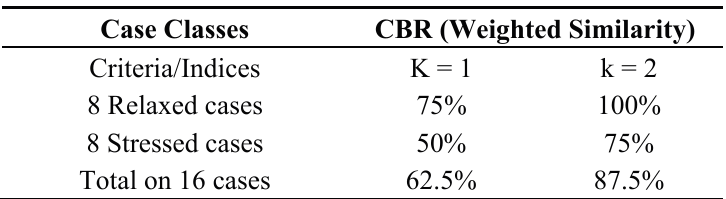
Table 2. Representation of percentage of correctly classified cases by the CBR weighted similarity.